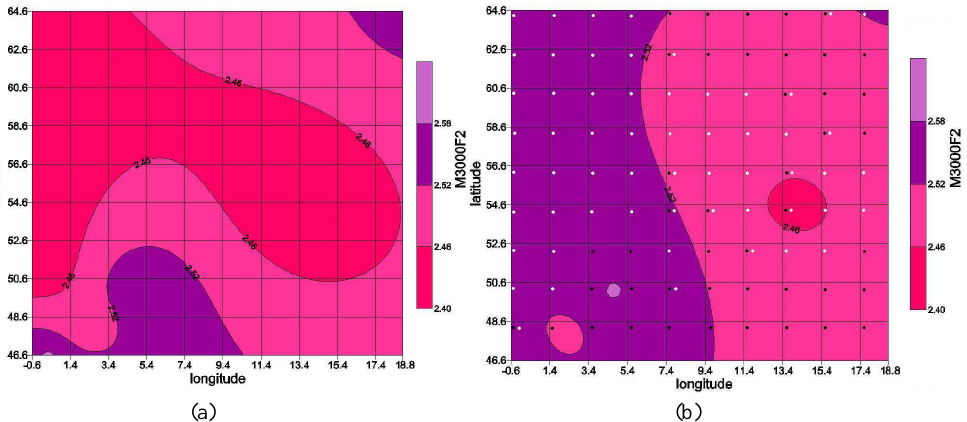
Fig. 6. Same as Fig. 5 but for a short-term forecasting of M3000F2 generated one hour in advance on 16 November 1991 at 01:00UT under disturbed geomagnetic activity (ap( τ = 0 . 8 ) = 24 . 8; ap( τ = 0 . 9 ) = 20 . 5) using the 8 forecasting local models simultaneously operative for the month of November (see Table 7b).